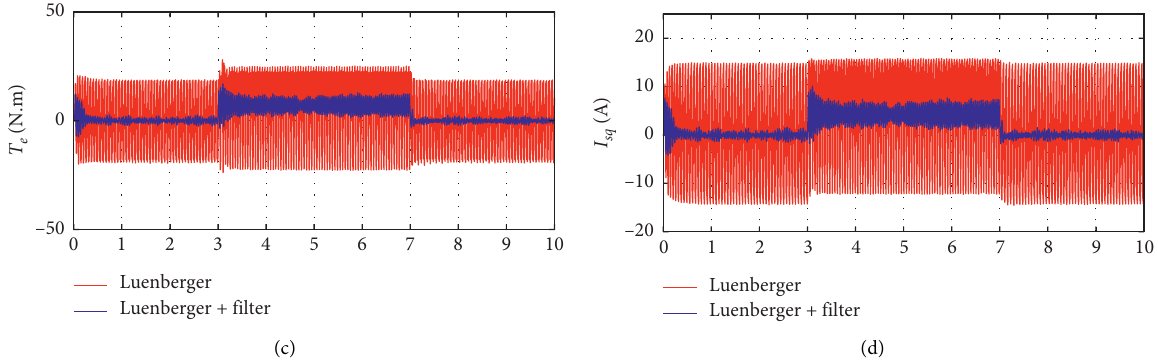
Figure 7: (a) Rotor speed. (b) Speed error. (c) Electromagnetic torque. (d) q -axis stator